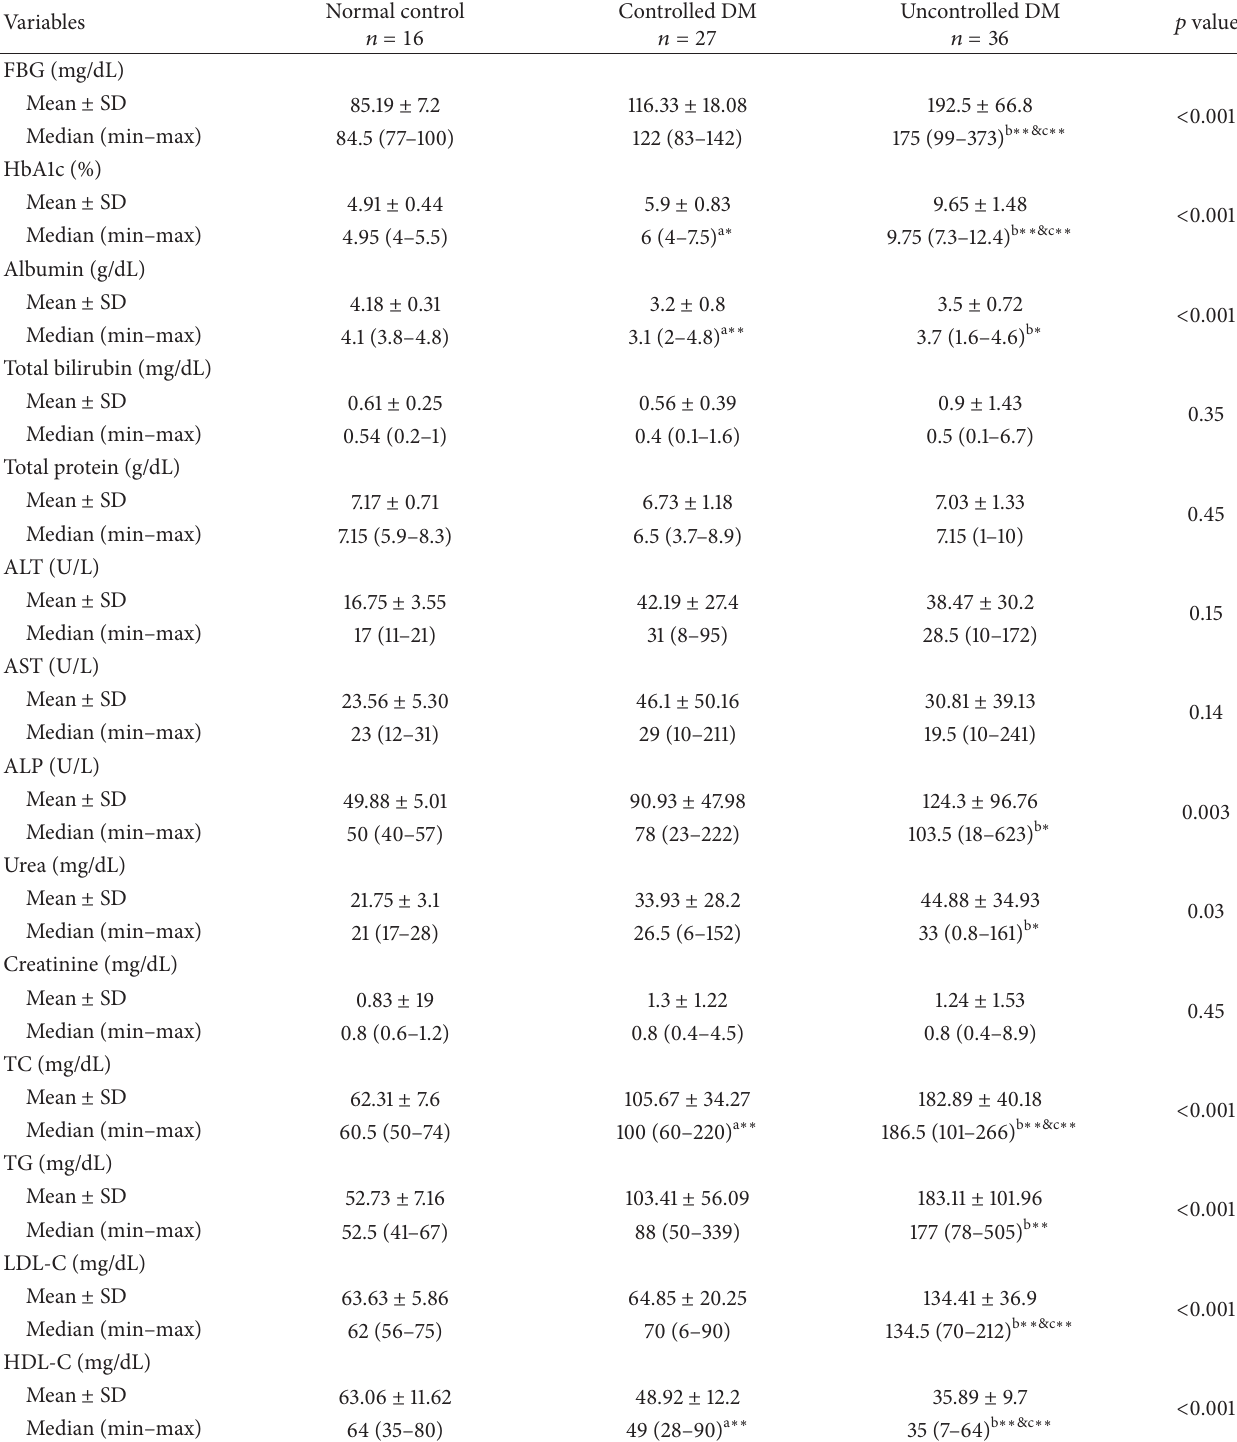
Table 1: Basic laboratory investigations in the different studied